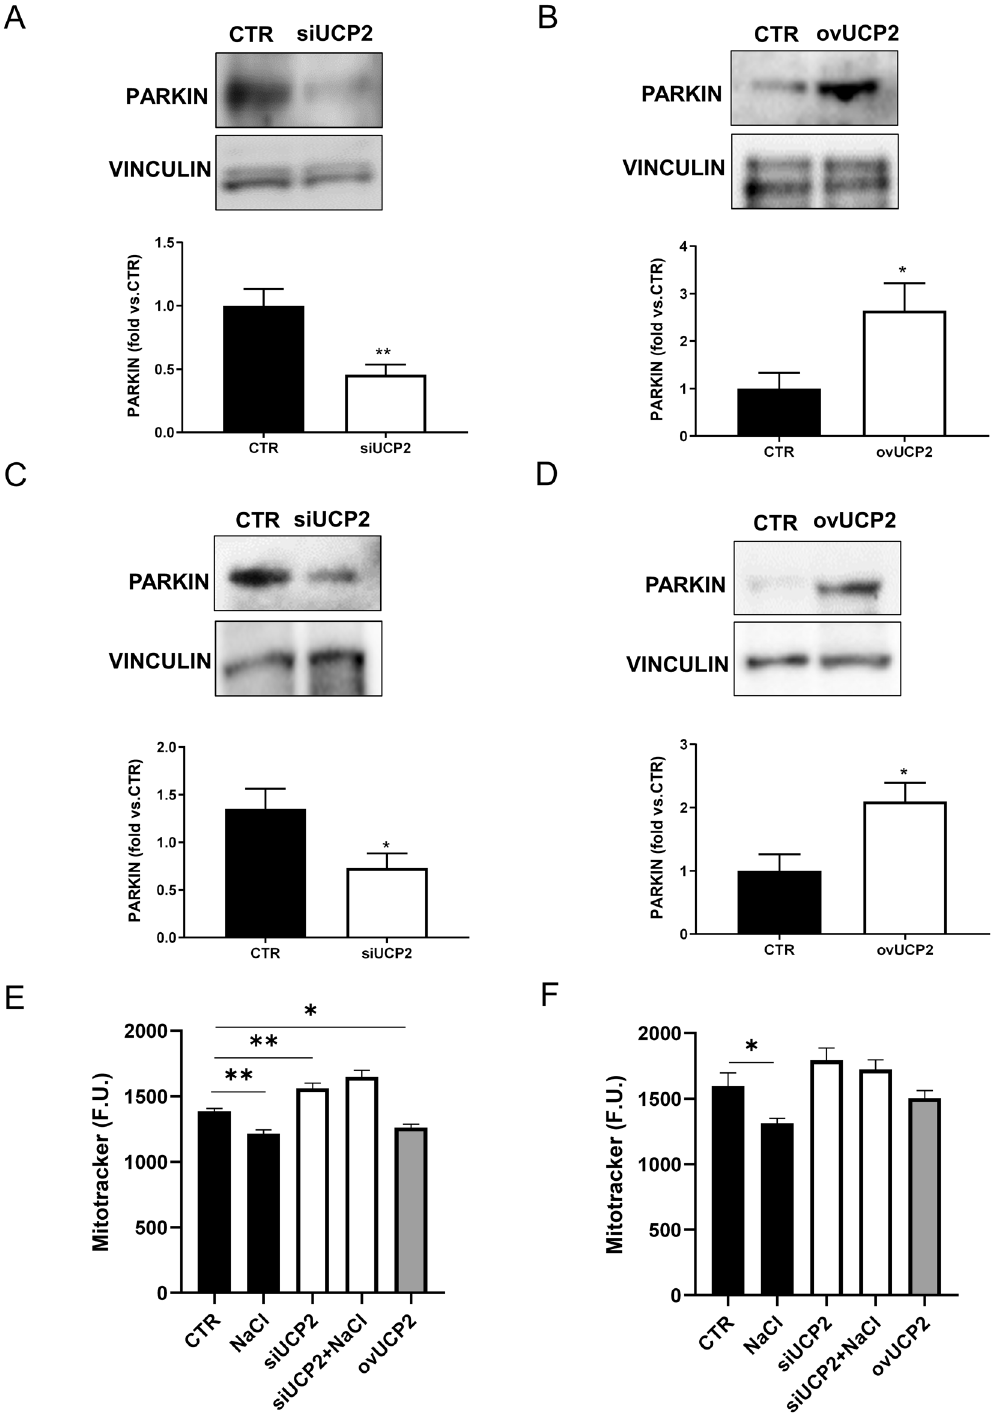
Fig. 5 UCP2 modulates mitophagy. Level of PARKIN in UCP2-silenced microvascular endothelial cells (siUCP2) ( A ) or cells overexpressing UCP2 (ovUCP2) for 24 h ( N = 4) ( B ). Level of PARKIN in renal proximal tubular epithelial cells silenced for UCP2 (siUCP2) ( C ) or overexpressing UCP2 (ovUCP2) for 24 h ( D ) ( N = 4). CTR indicates not transfected cells. Representative western blots of PARKIN and corresponding quanti fi cation are reported. * p < 0.05, ** p < 0.001 obtained using the two-tailed students t -test. E , F Analysis of mitophagy through MitoTracker green (F.U., fl uorescent units) in high-salt- treated siUCP2 or ovUCP2 microvascular endothelial cells ( E ) and renal proximal tubular epithelial cells ( F ) ( N = 12). * p < 0.05, ** p < 0.001 obtained using the one-way ANOVA followed by Bonferroni post hoc analysis. Data are reported as mean ±